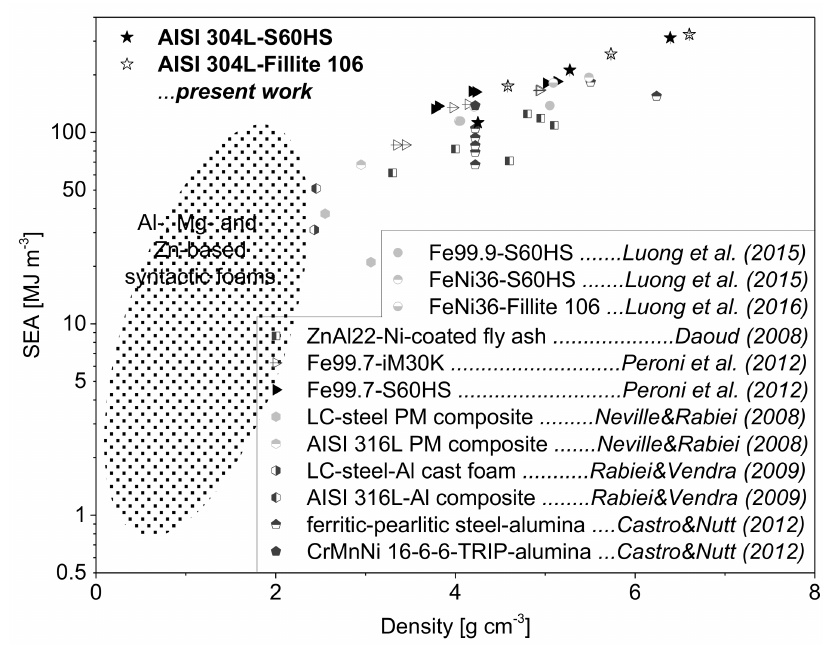
Figure 16. Comparison of the specific energy absorption (SEA) of different syntactic metallic foams under quasi-static loading; the ellipsoid strength region was extrapolated from literature